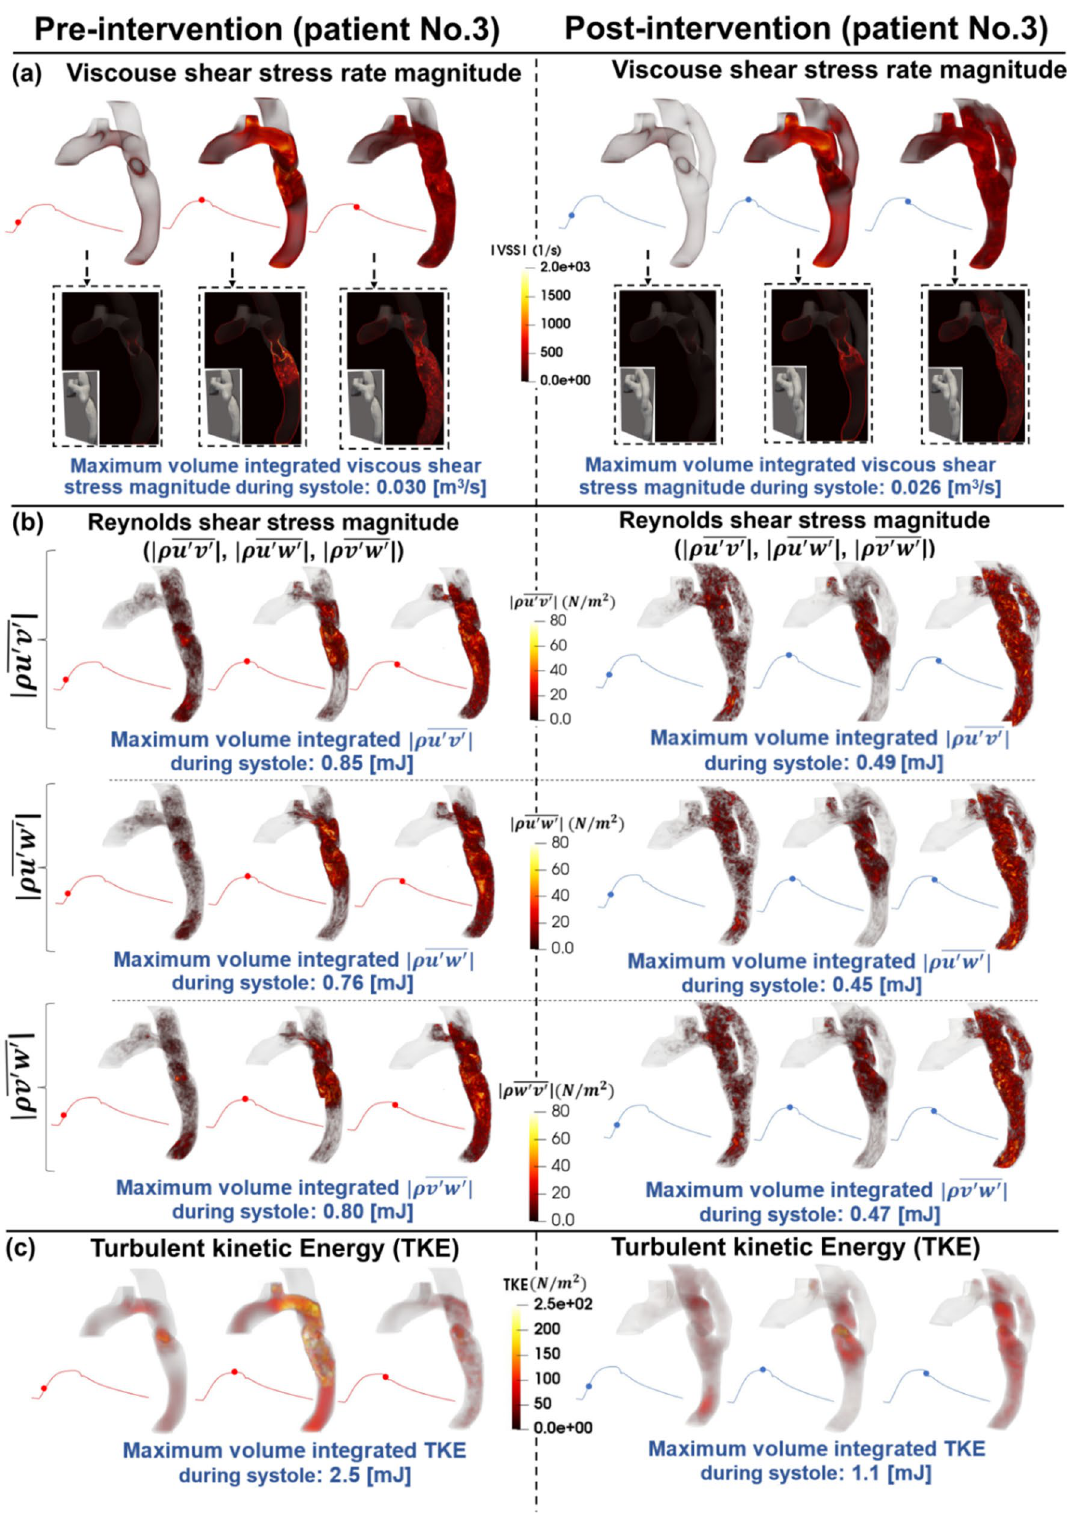
Figure 8. Flow modeling in Patient No. 3 in pre and post intervention status. ( a ) Viscous shear stress (VSS) magnitude; ( b ) Computed Reynolds Shear stress ( ρ u ′ v ′ , ρ u ′ w ′ and ρ w ′ v ′ ) magnitude; ( c ) Turbulent kinetic u ′ 2 + v ′ 2 + w ′ 2 energy (TKE), computed as 1 2 ρ , where u, v, w and ρ correspond to the three components of the instantaneous velocity vector and density. The bar and prime denote the ensemble averaged and fluctuating (cid:30) (cid:31) components,